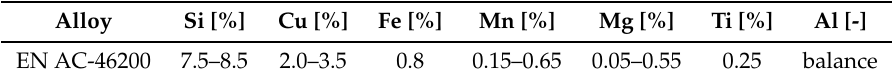
Table 1. Nominal chemical composition of the investigated cast alloy in weight percent [63].